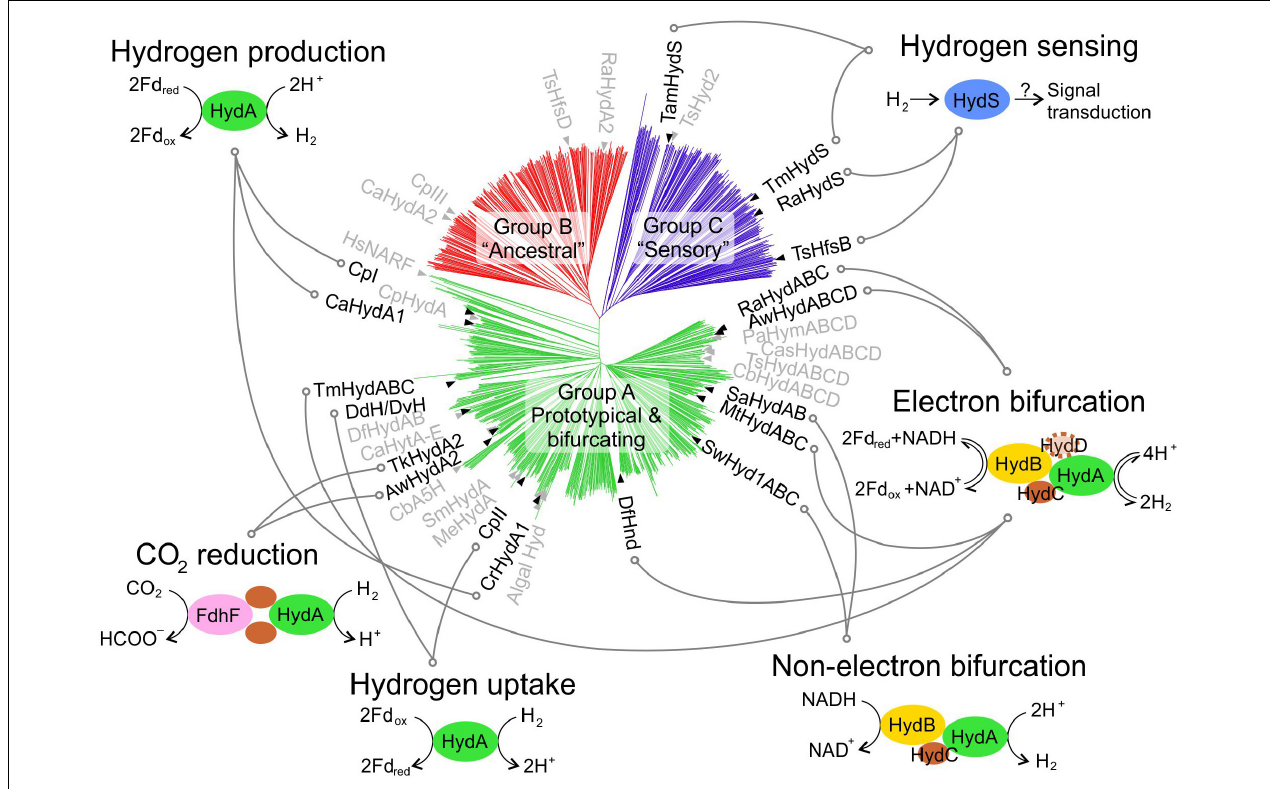
FIGURE 1 | [FeFe]-hydrogenases phylogeny and known functions. A phylogenetic tree shows the phylogeny of [FeFe]-hydrogenase sequences from public databases, as previously proposed (Greening et al., 2016). Enzymes that have been experimentally characterised are indicated on the tree to show their relative position. The proposed physiological function of each enzyme is also presented, where known. A full list of enzymes is available in Supplementary Table 1 , including details on the enzyme identifier/acronym used here. Hyd, hydrogenase subunit; FdhF, formate dehydrogenase subunit; Fd rex / ox , reduced/oxidised ferredoxin; NADH/NAD + , reduced/oxidised nicotinamide adenine